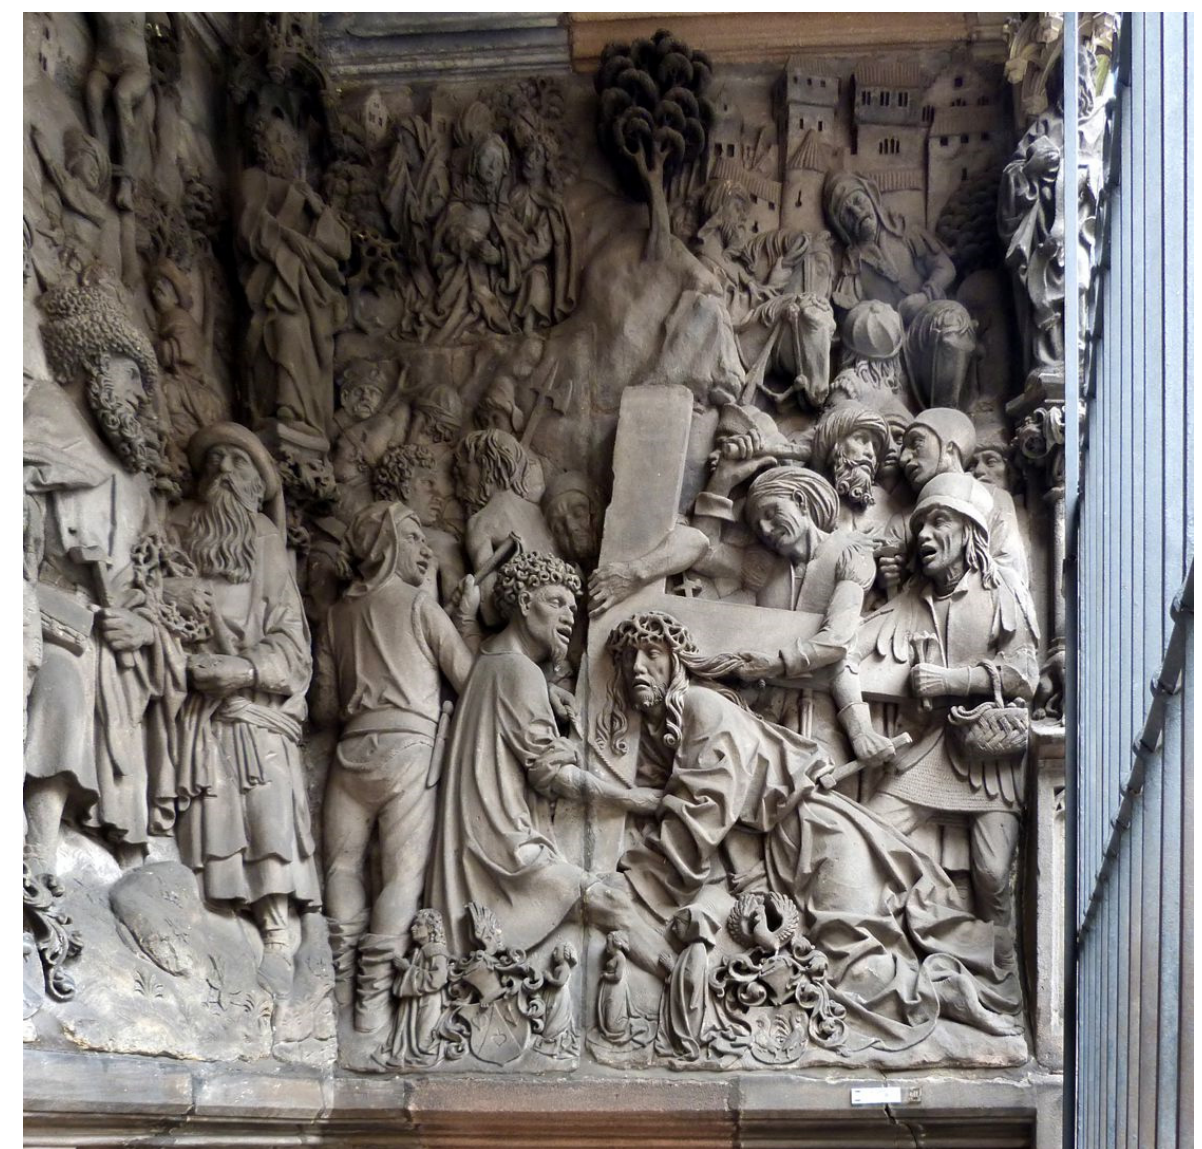
Figure 6. Kraft, Schreyer–Landau Epitaph. Detail: Christ Carrying the Cross.